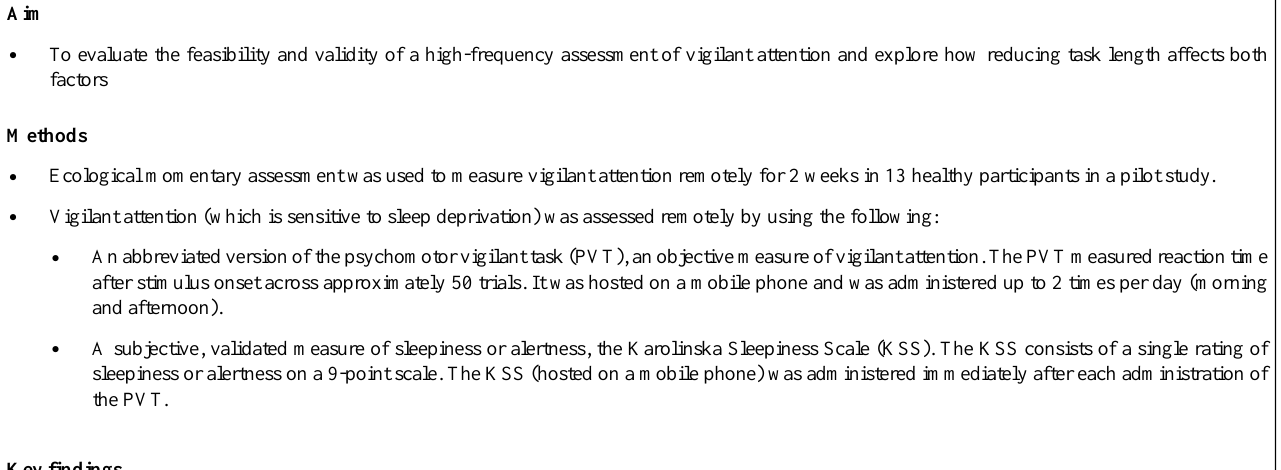
Textbox 3. Comparing different high-frequency assessments.